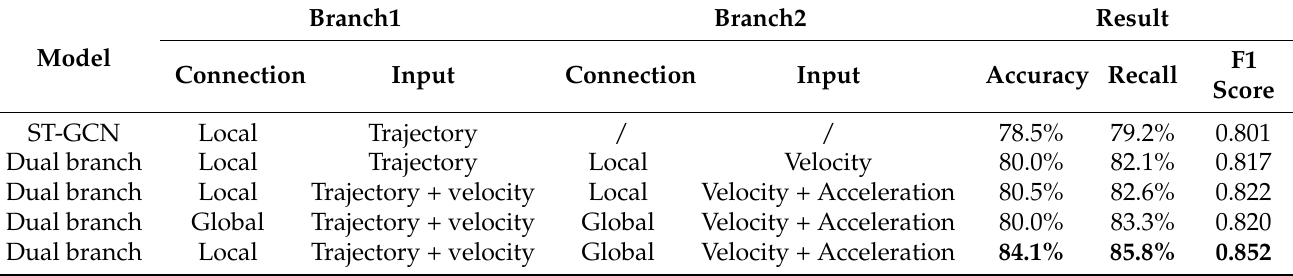
Table 3. The influence of global connections and motion